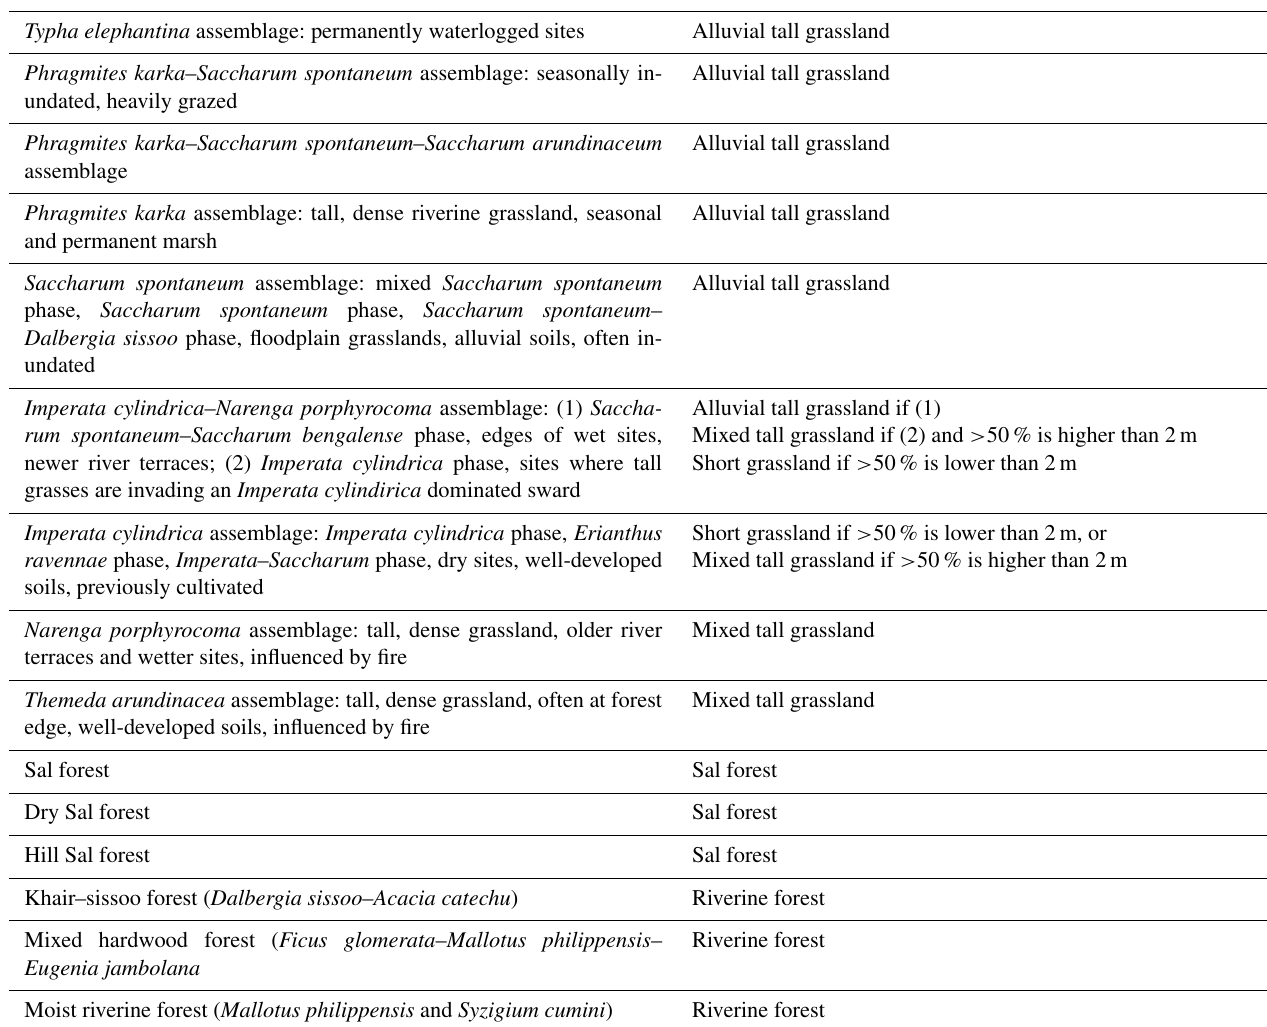
Table C1. Grouping of vegetation types. Vegetation assemblages present in Bardia National Park and their associated vegetation classes as used in the level 2 classification model in this study. Grass assemblages are from Peet et al. (1999a). Forest assemblages are